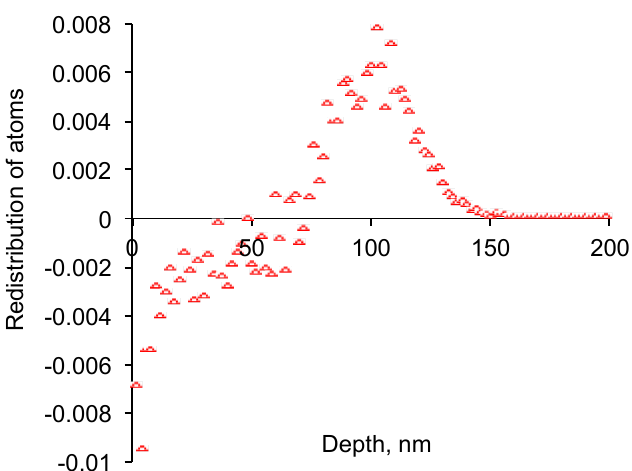
Figure 4. The total atoms balance (nitrogen, carbon and hydrogen, units are replaced atoms/nm 3 per penetrated nitrogen ion/nm 2 ) with depth of EPDM rubber. By SRIM calculations.